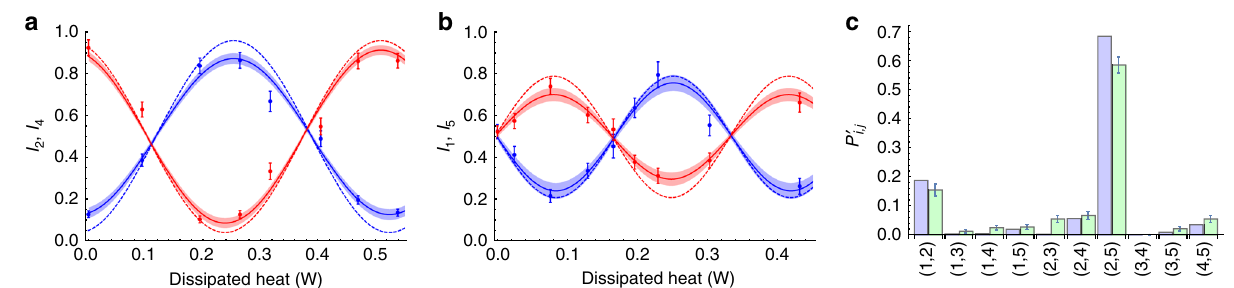
Fig. 4 Measurements with the entanglement characterisation chip. a Interference fringes for I 2 (blue points) and I 4 (red points) as a function of the dissipated heat on mode 2 (proportional to ϕ 2 ). b Interference fringes for I 1 (blue points) and I 5 (red points) as a function of the dissipated heat on mode 5 (proportional to ϕ 5 ). In both a , b , solid lines and shaded areas represent respectively the best fi t curves and 1 σ fi t, while the dashed lines corresponds to theoretical predictions. The latter is obtained by considering that the QTC followed by each of the directional coupler of the ECC can be considered as a Mach – Zehnder interferometer. Hence, the adopted best fi t model for the experimental data was a + b cos( c + 2 π x / d ). c Green bars: two-photon probability distribution obtained at the output of the second chip, when the polarisation-entangled anti-symmetric state is injected into input 2 and 4 of the fi rst chip. The distribution is obtained for values of the two phases which maximise P ′ ; blue bars: theoretical predictions. All theoretical models are obtained taking 25 into account the reconstructed matrices of the fi rst chip ( ~ U H and ~ U V ) and the coupling ef fi ciencies at the interface between the two devices (Supplementary Notes 7 and 9). Error bars in the plots are 1 σ intervals and are due to the poissonian statistics of the coincidence events. Typical coincidence rates in this regime are ~500/h for all output con fi gurations